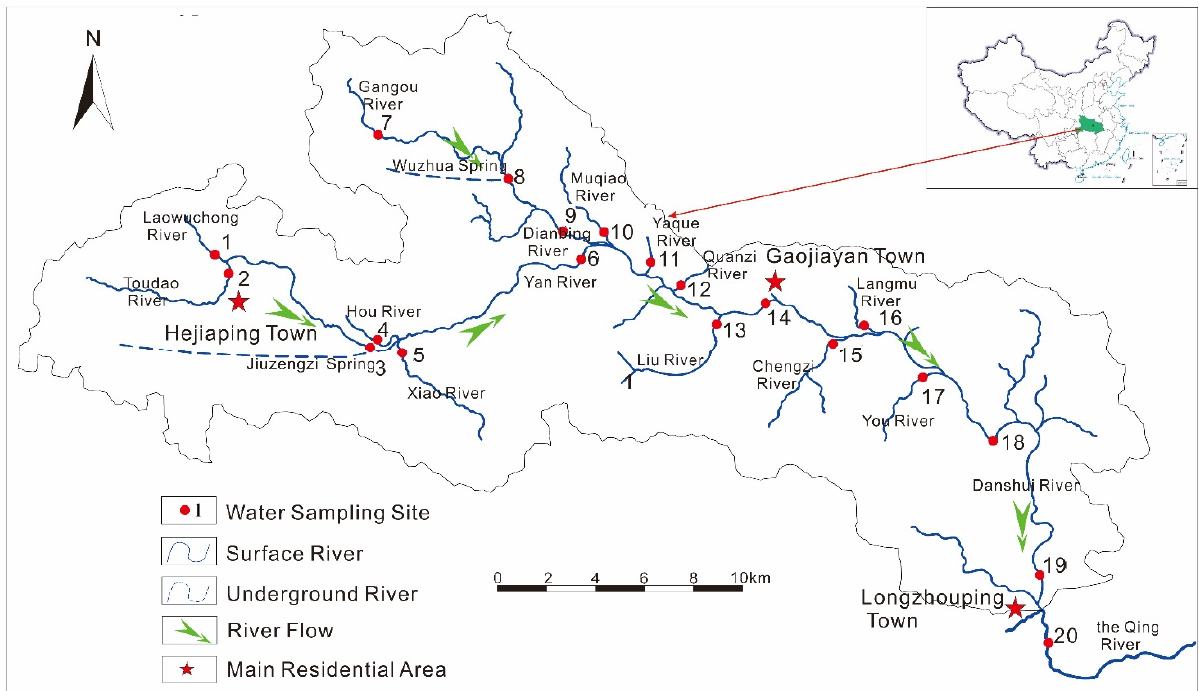
Figure 1. The location and sampling sites in the Danshui River.